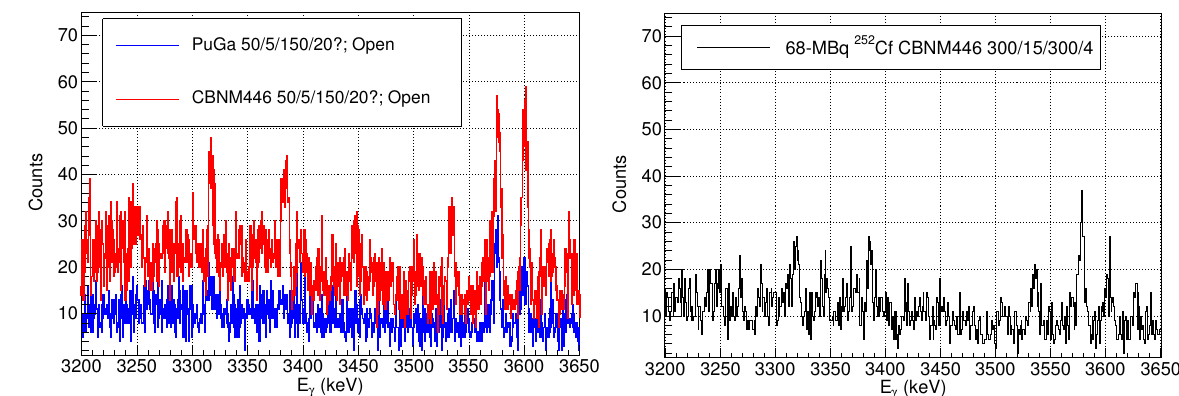
Figure 1: Measured spectra using PUNITA [3] (left) and a 252 Cf source in PERLA [4]